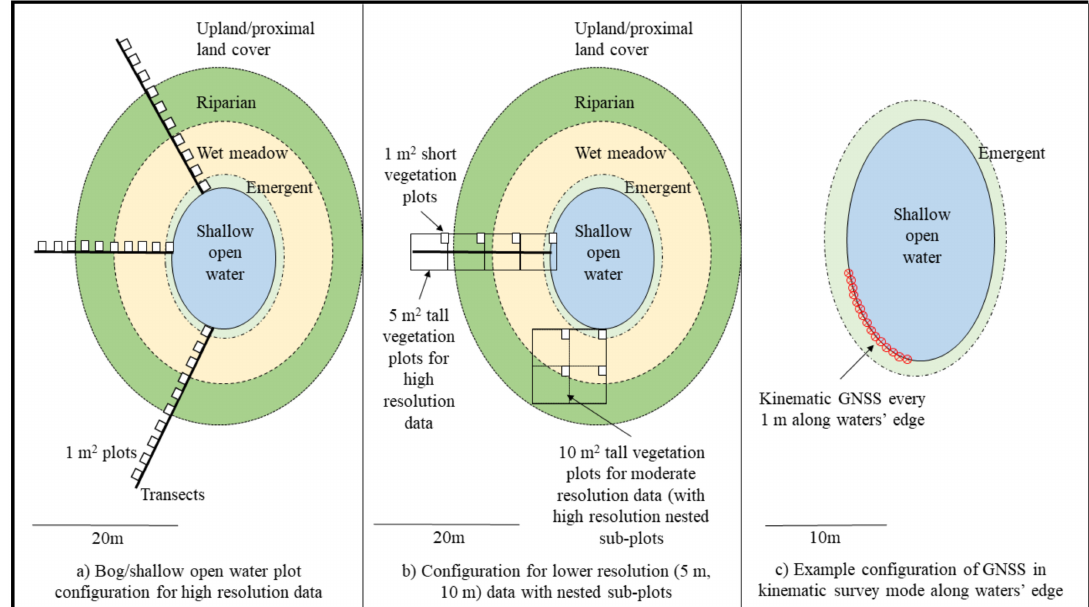
Figure 6. Illustration of transect and plot set up example for ( a ) high resolution data (~1 m 2 ), ( b ) moderate resolution data (10 m 2 ) with understory plots and ( c ) kinematic survey along the waters’ edge required for validation of water